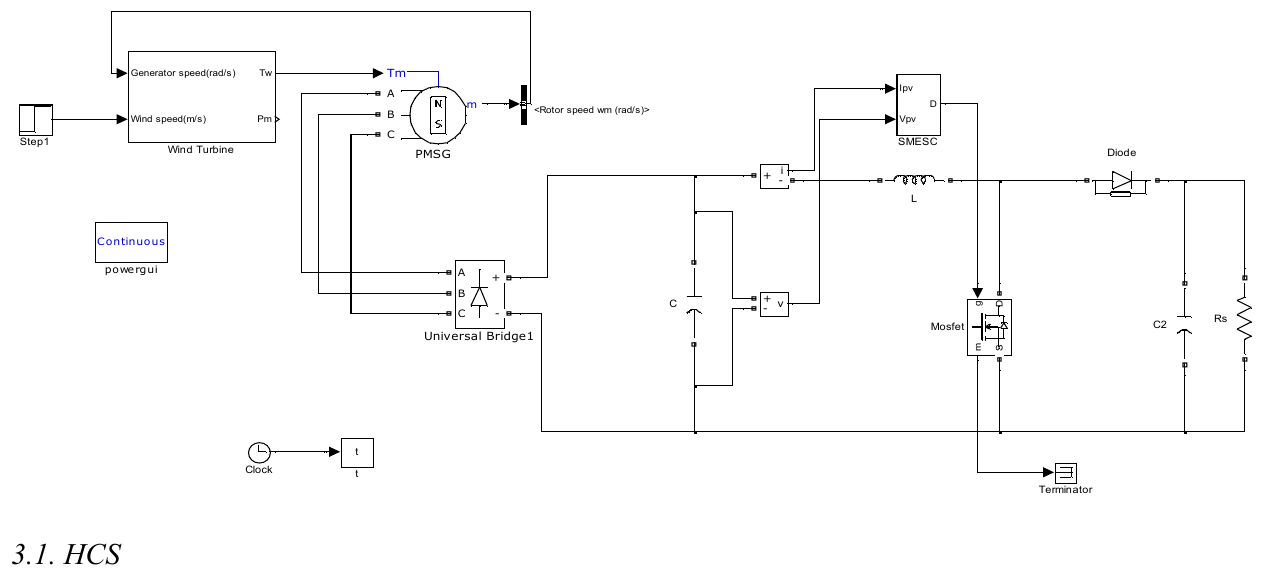
Figure 4. Wind power system simulation built in this